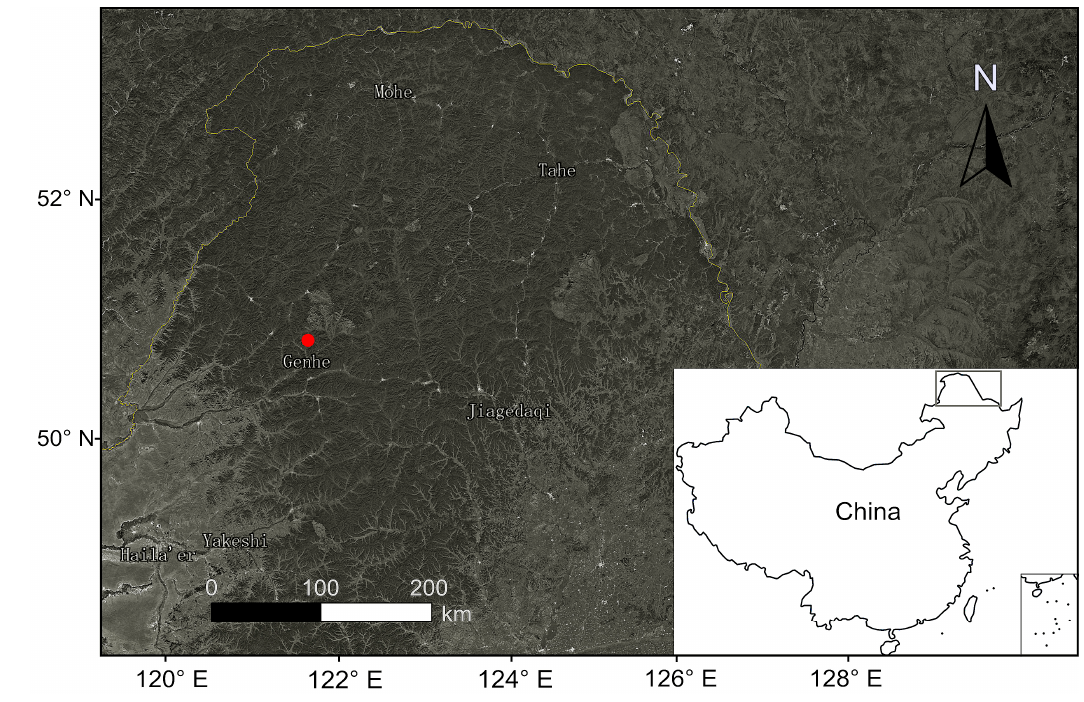
Figure 1. Location of the study area (the red point).